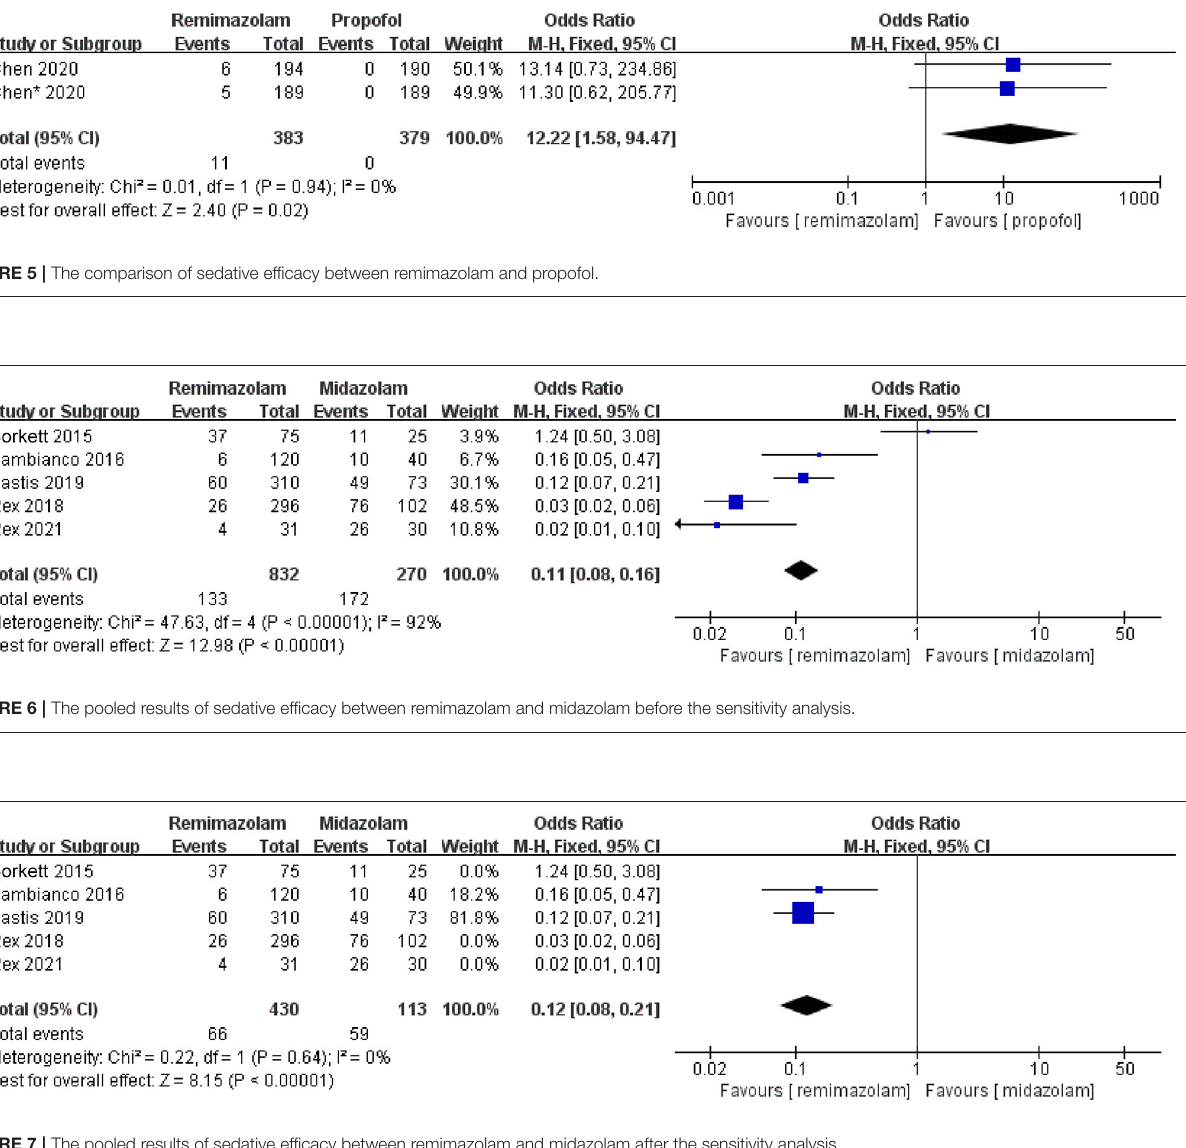
Frontiers in Medicine | www.frontiersin.org